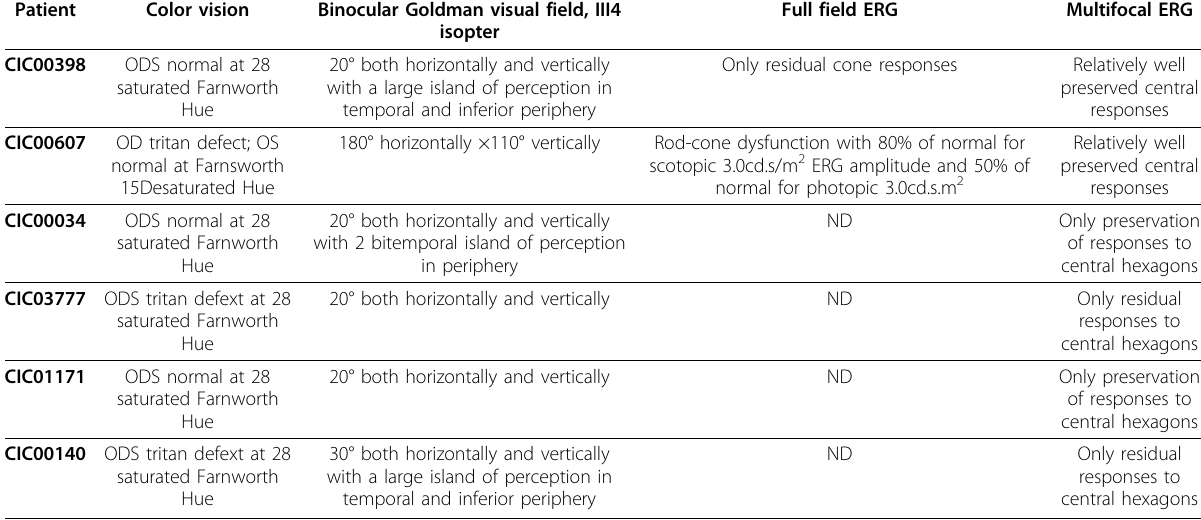
Table 4 Functional data.